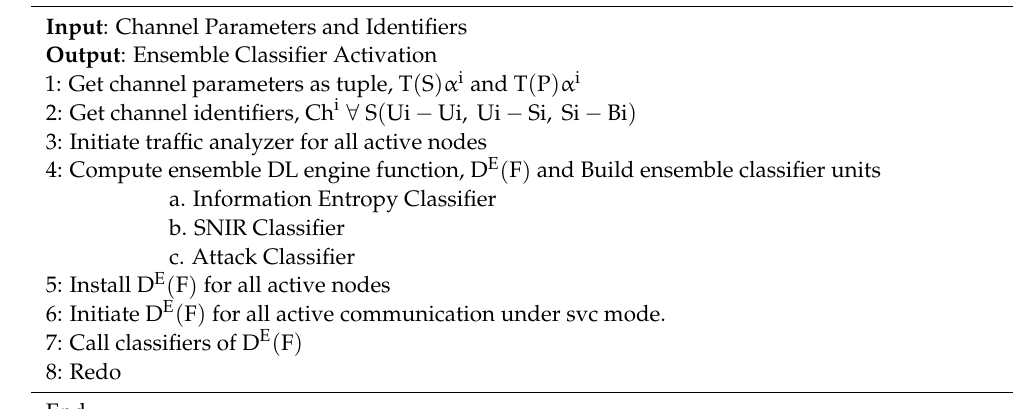
Algorithm 1: Multi-Channel Interference and Energy Modelling Procedure